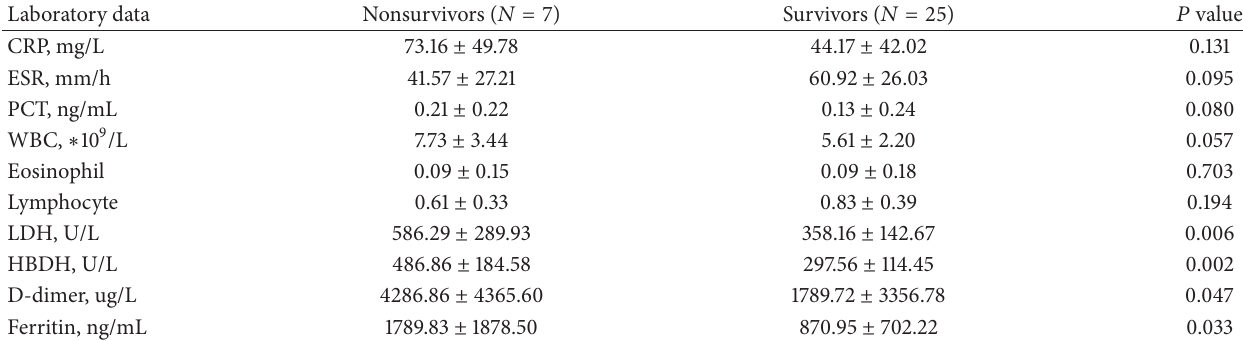
Table 4: Comparisons of biomarkers between nonsurvivors and survivors of AIDS PCP